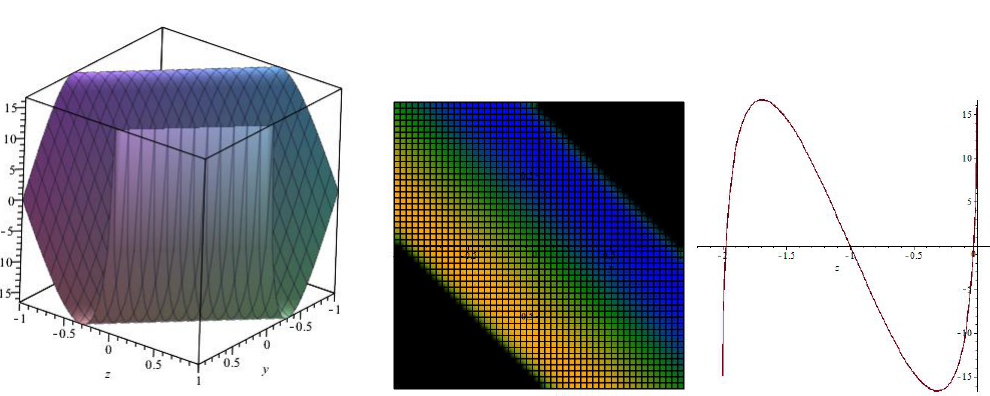
Figure 1. Profiles of solution